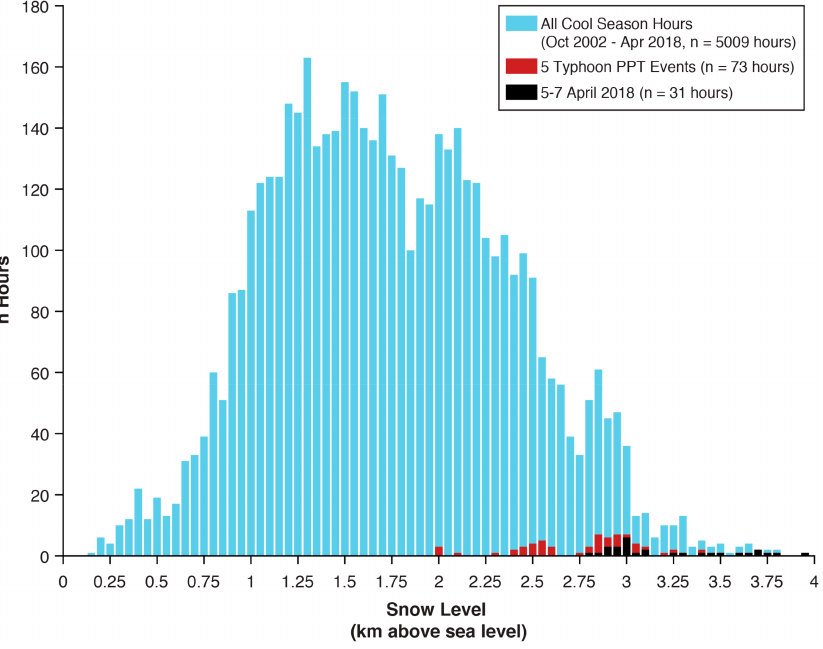
Figure 5. Histogram of hours of observed snow levels (km) at Chico, California for all cool seasons (October–April; blue bars), five other typhoon remnant-related precipitation (PPT) events (red bars; composed of six typhoon remnants), and the 5–7 April 2018 event (black